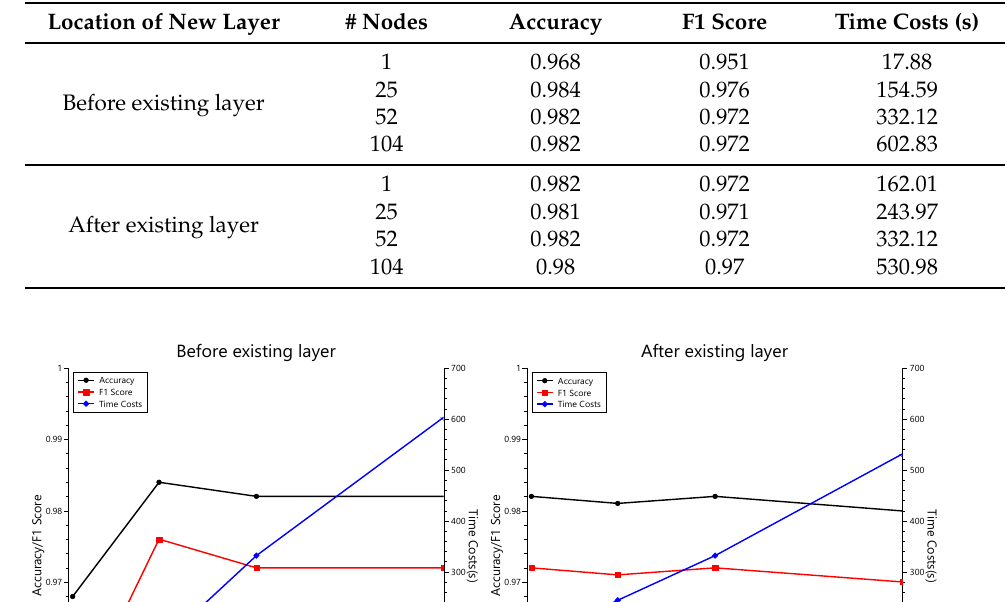
Table 7. The hyperparameter optimization result for double hidden layers.